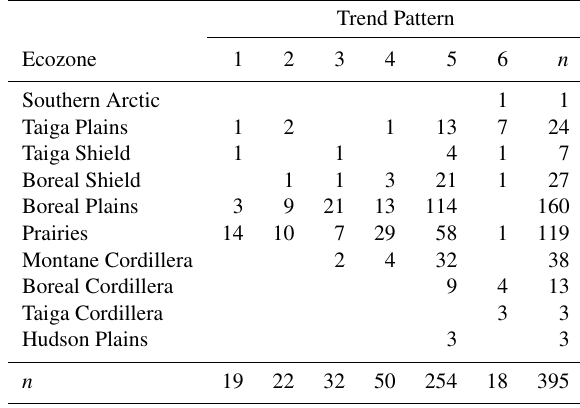
Table 6. Trend Patterns in relation to the ecozone in which the sta- tion is